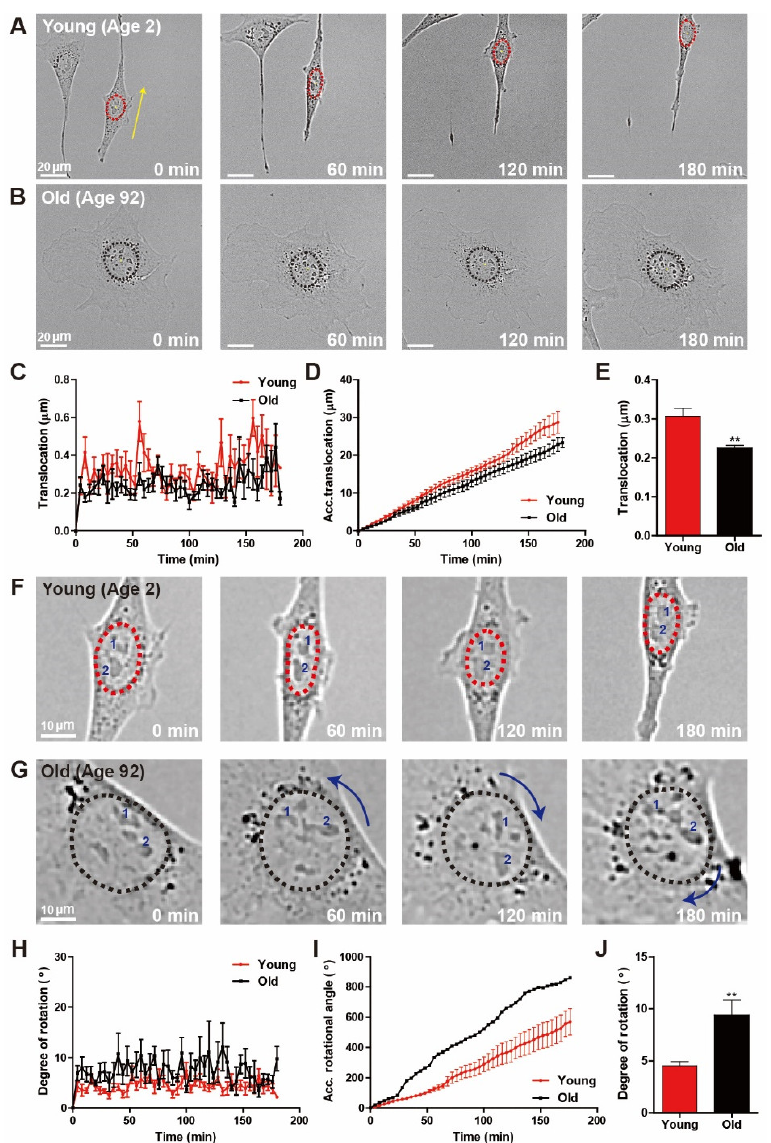
Figure 3. Age-dependent distinct nuclear motion. ( A – E ) Time-lapse monitoring of nuclear translocation during random migration of young and old HDFs. Elongated nuclei of young HDFs showed translocation, while nuclear rotation was dominant in round nuclei of old HDFs ( A , B ). Dotted lines delineate the nuclear boundary and arrows represent the magnitude of longitudinal displacement of nuclei. Quantification of displacement of nuclear centroids every 4 min for 3 h indicated that nuclei of young HDFs underwent more significant translocation than nuclei of old HDFs ( C – E ). ( F – J ) Time-lapse monitoring of nuclear rotation during random migration of young and old HDFs. Nuclear rotation was more frequently observed in old HDFs displaying round nuclear shape than that of nuclei of young HDFs typically displaying elongated nuclear shape ( F , G ). Dotted lines delineate nuclear boundaries, numbers inside the nuclei indicate the nucleoli, and curved arrows represent the magnitude of the rotational angle of the nuclei. The rotational angle quantified by the inner product of the centroid-pointing vectors of the nuclei and nucleoli indicate that nuclear rotation was more dominant in old HDFs ( H – J ). See more details on quantification of nuclear rotation in Materials and Methods. In panels ( C – E ) and ( H – J ), > 10 cells were analyzed for each condition. Error bars indicate S.E.M. and statistical di ff erences were calculated using the unpaired t -test. ** p <